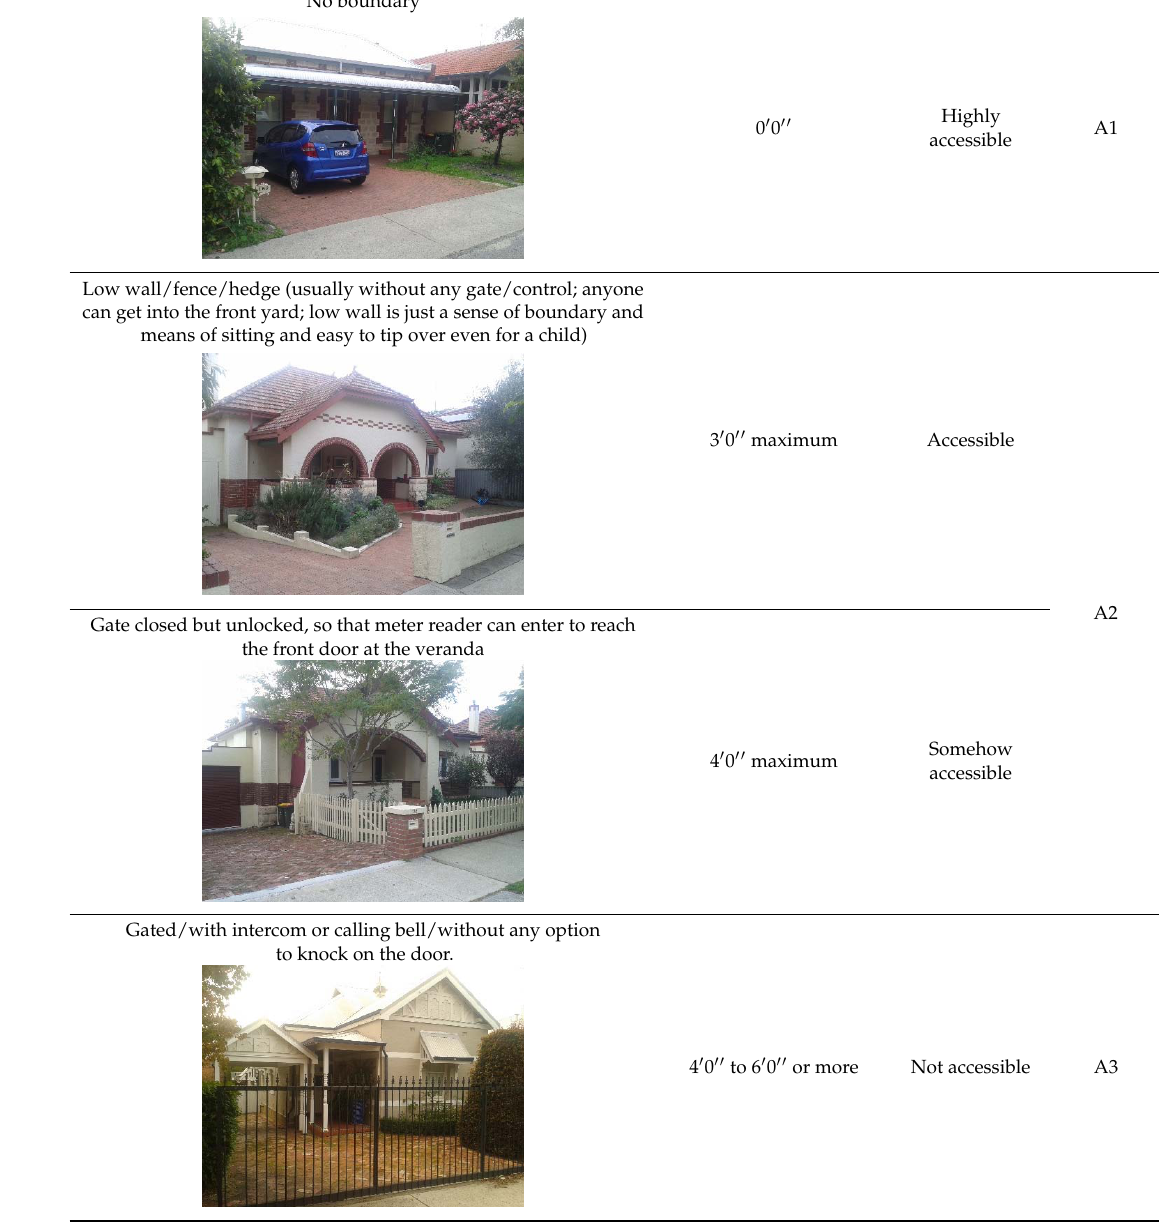
Table 3. Types of visual permeability.